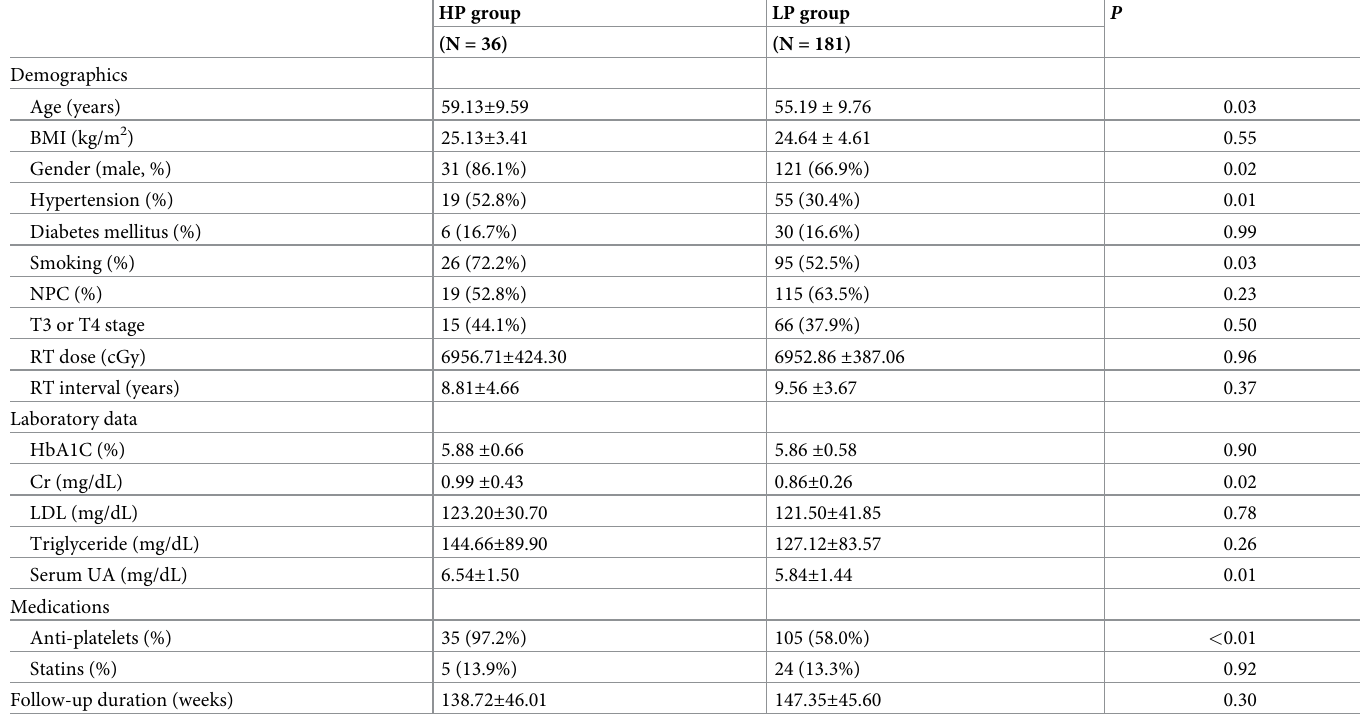
Table 2. Baseline characteristics between the high (HP) and low plaque (LP) score